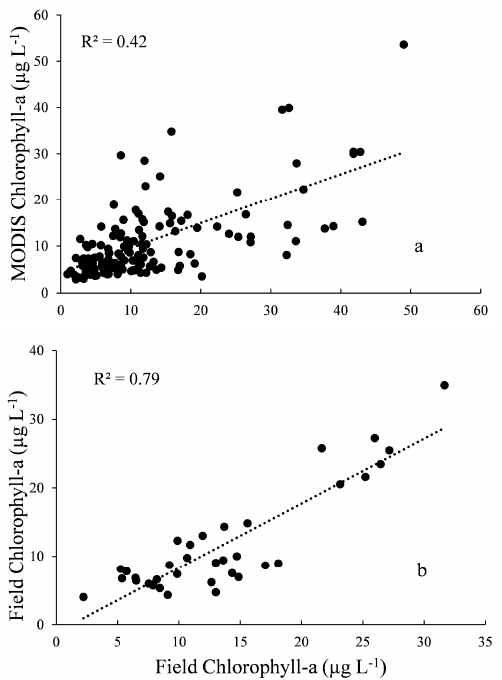
Figure 2. The estimated chlorophyll-a concentration from MODIS was compared with in situ field sampling: ( a ) each MODIS chlorophyll-a value was extracted from the pixel centered at field sampling location and compared with the sampled chlorophyll-a at that location of the same day, ( b ) all samples at different locations but within a month were averaged and compared with the average MODIS chlorophyll-a value of the same month at pixels centered on these